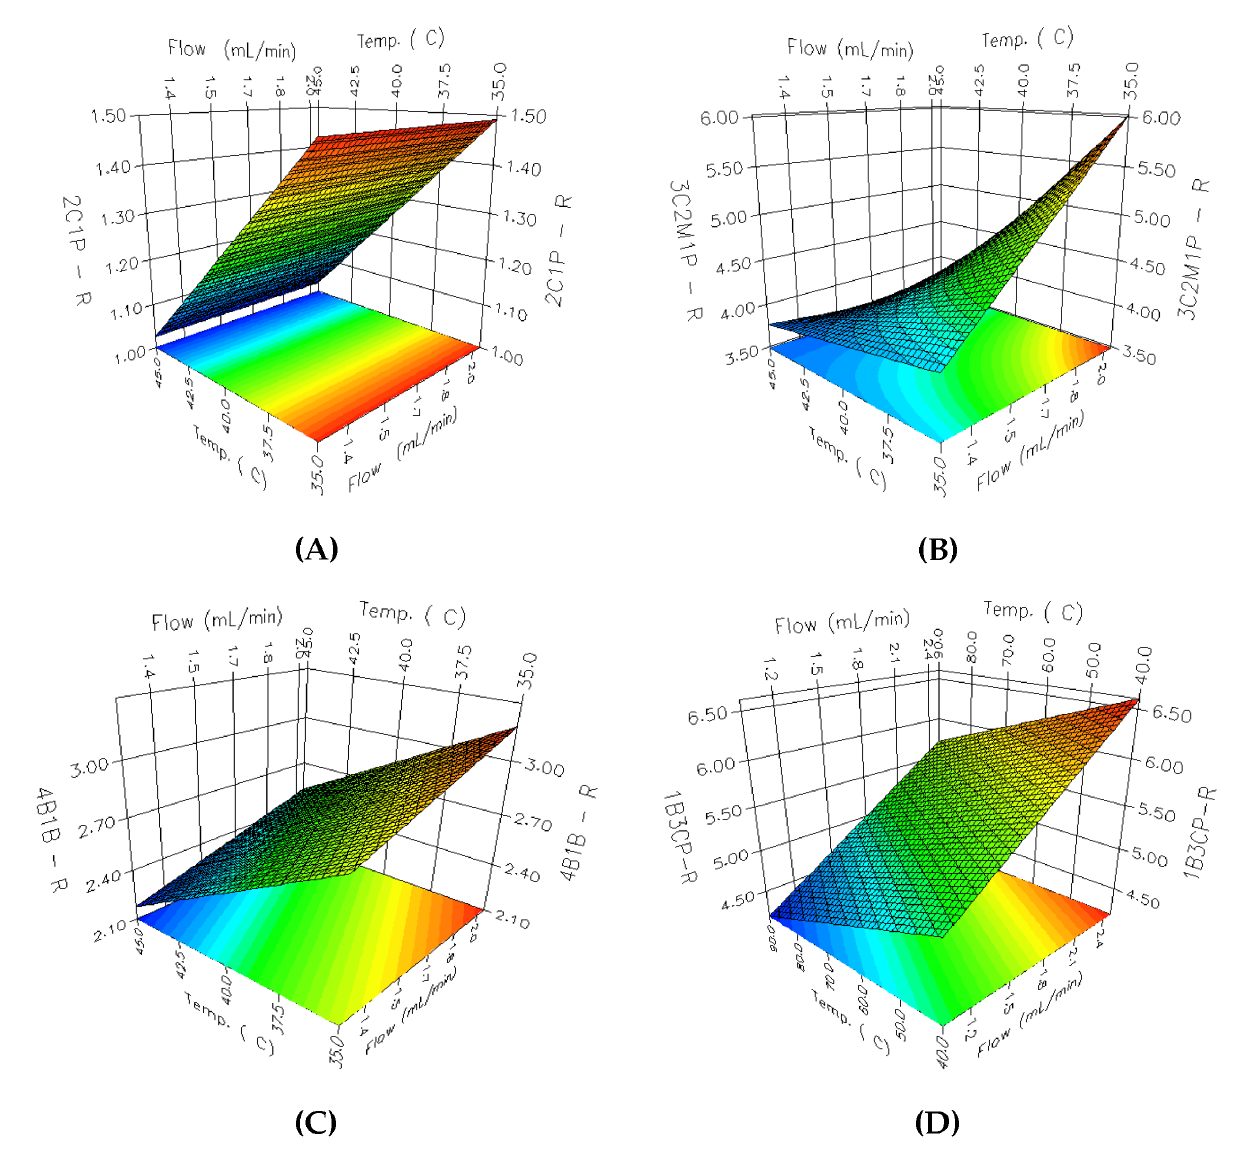
Figure 4. The 3D response surface plots for the resolution: ( A ) 2C1P; ( B ) 3C2M1P; ( C ) 4B1B; ( D )